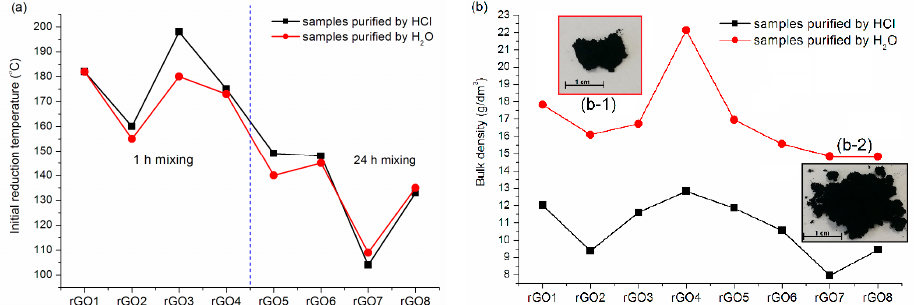
Figure 4. ( a ) Diagram of the initial reduction temperatures for individual graphene oxides; ( b ) diagram of the bulk density determined for graphene oxides neutralized or purified with hydrochloric acid; ( b-1 ) picture of rGO purified by H 2 O; ( b-2 ) picture of rGO purified by HCl.